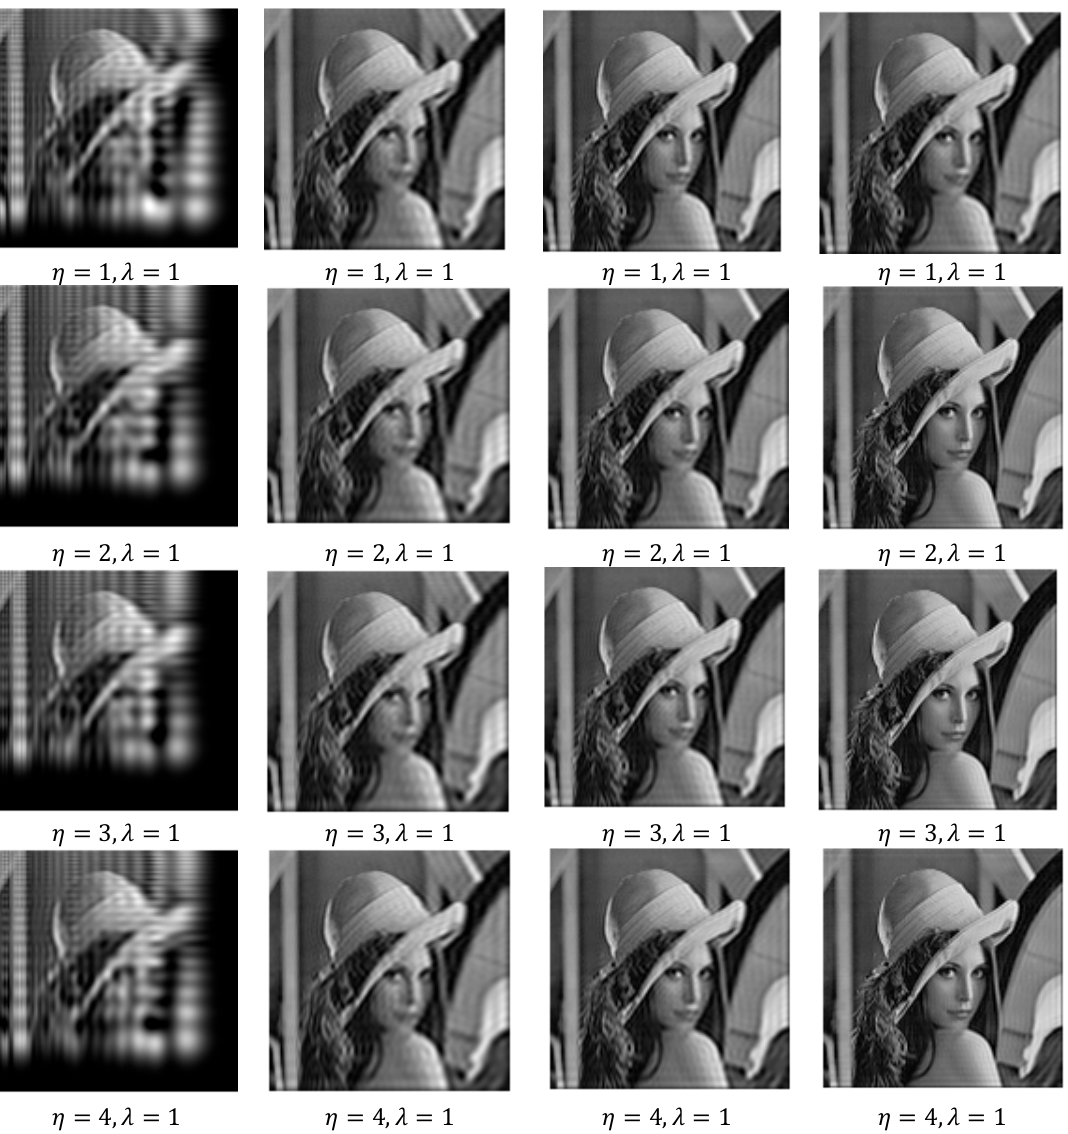
Figure 8. Columns 1 to 4 shows the reconstructed by using GFLMs gray-level images with order 50, 100, 150, and 300, respectively.